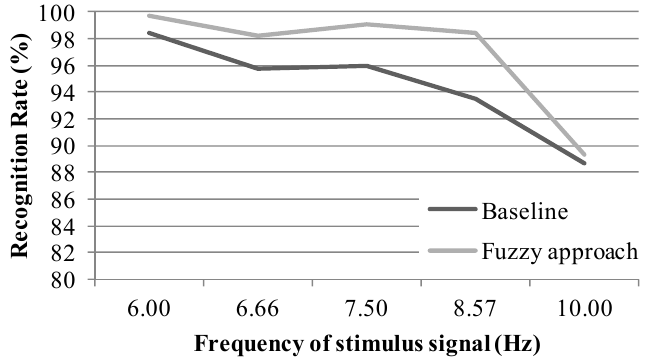
Figure 8. Experimental results for different stimulus signals.